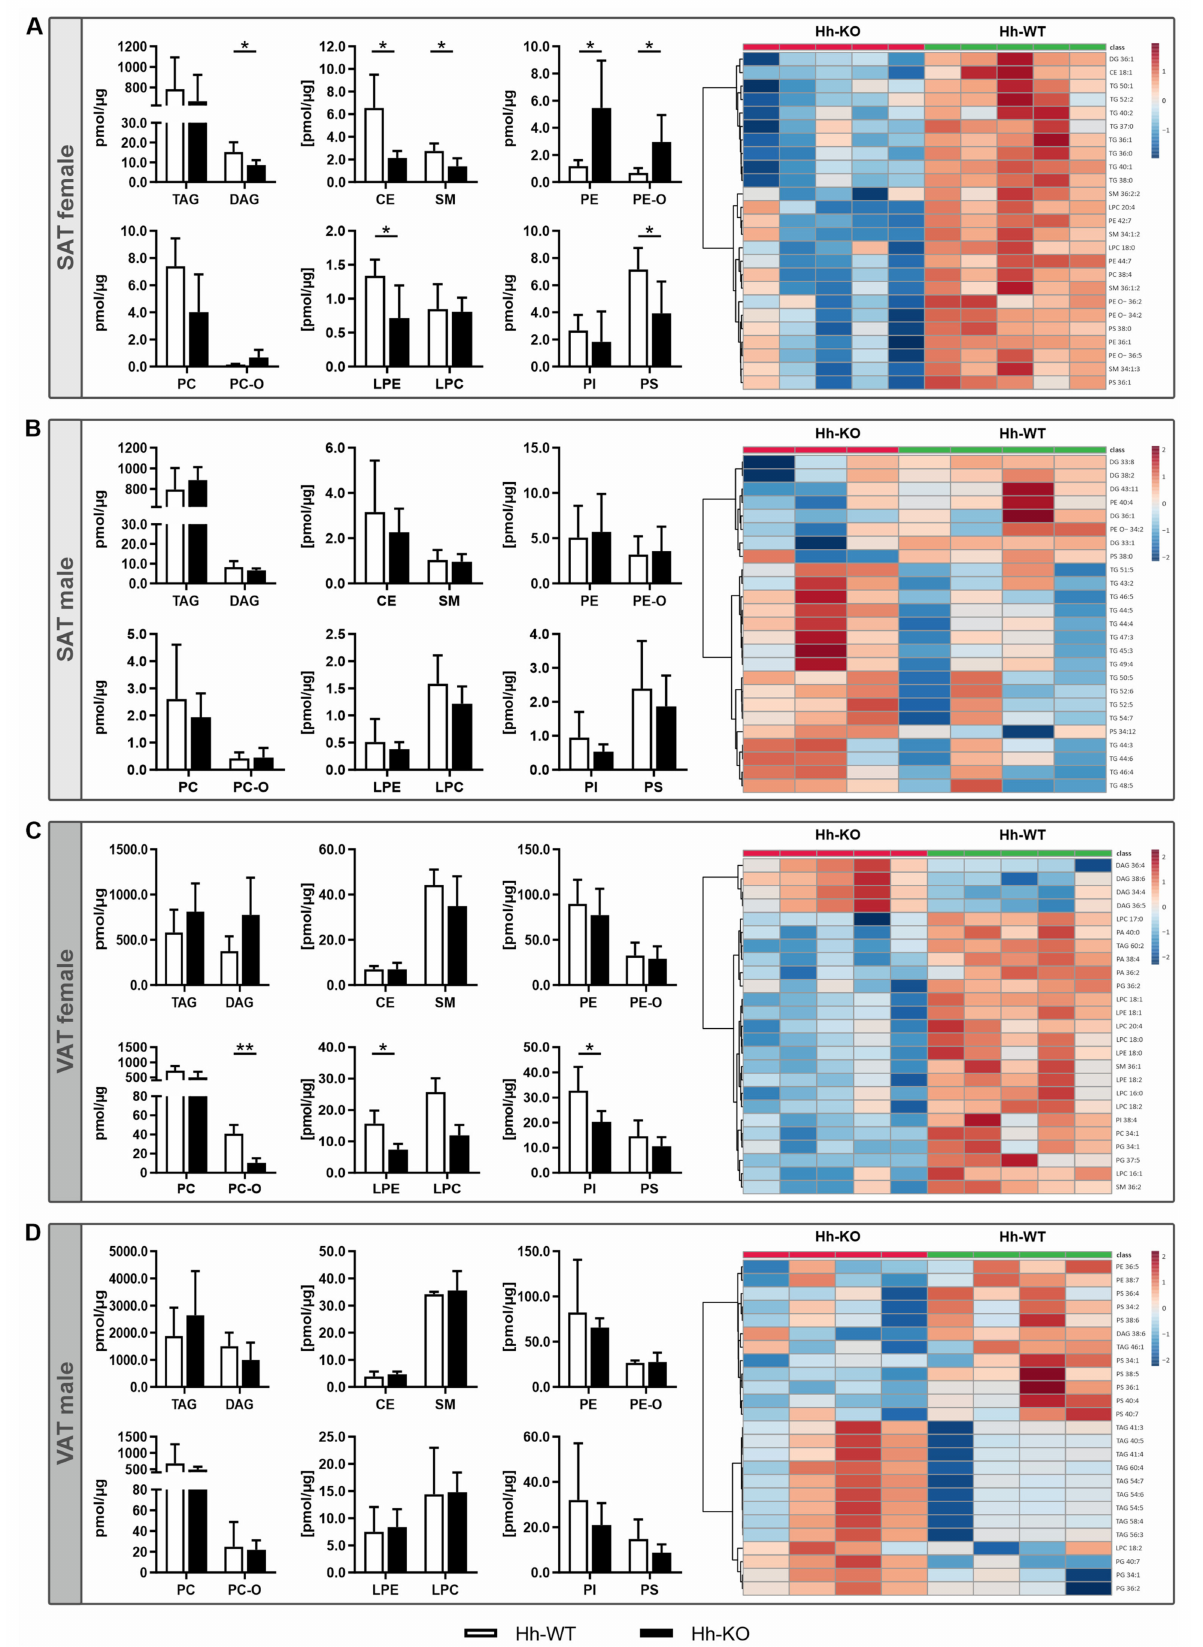
Figure 2. Lipidomic profiles of adipose tissue. Shotgun lipidomic analyses were performed on SAT and VAT from male and female Hh-WT and Hh-KO mice. n = 3–5. ( A – D ) Quantification